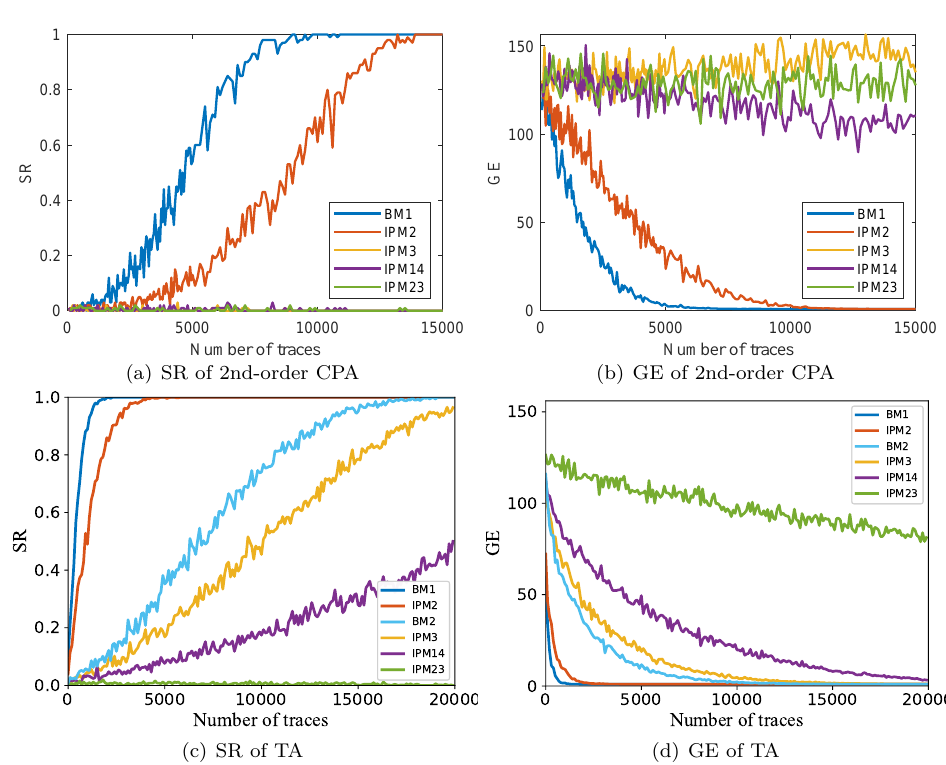
Figure 4: SR and GE results for both 2nd-order CPA and TA on non-redundant